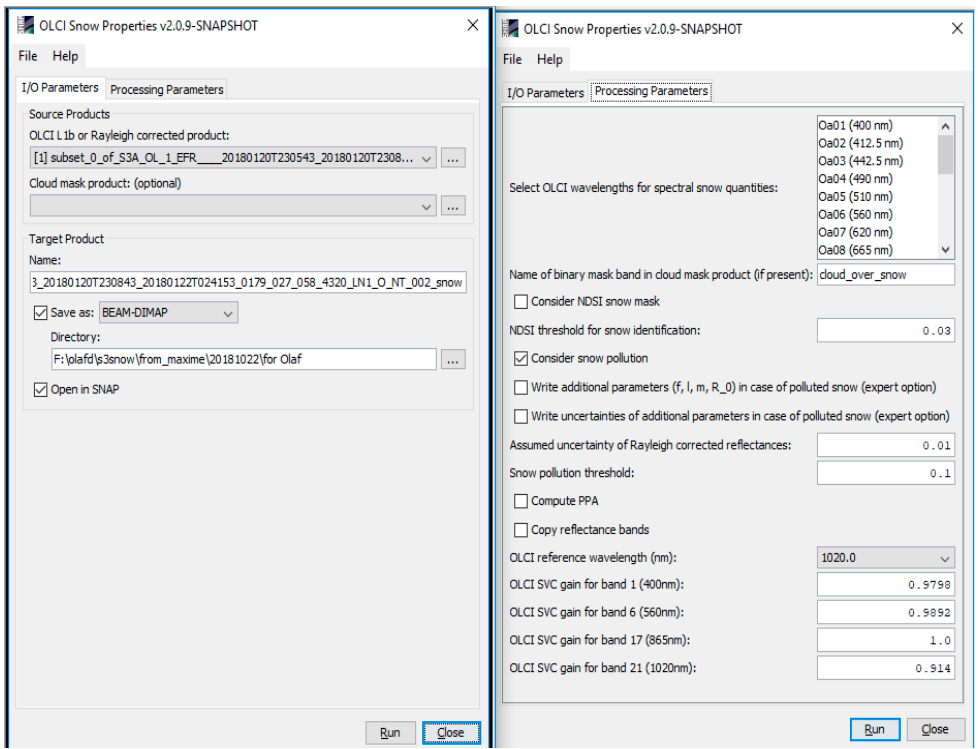
Figure 7. The Sentinel Application Platform (SNAP) Snow Properties Processor: Input/Output (I/O) and processing parameters tabs. Table 1. Bands in the final snow properties product.